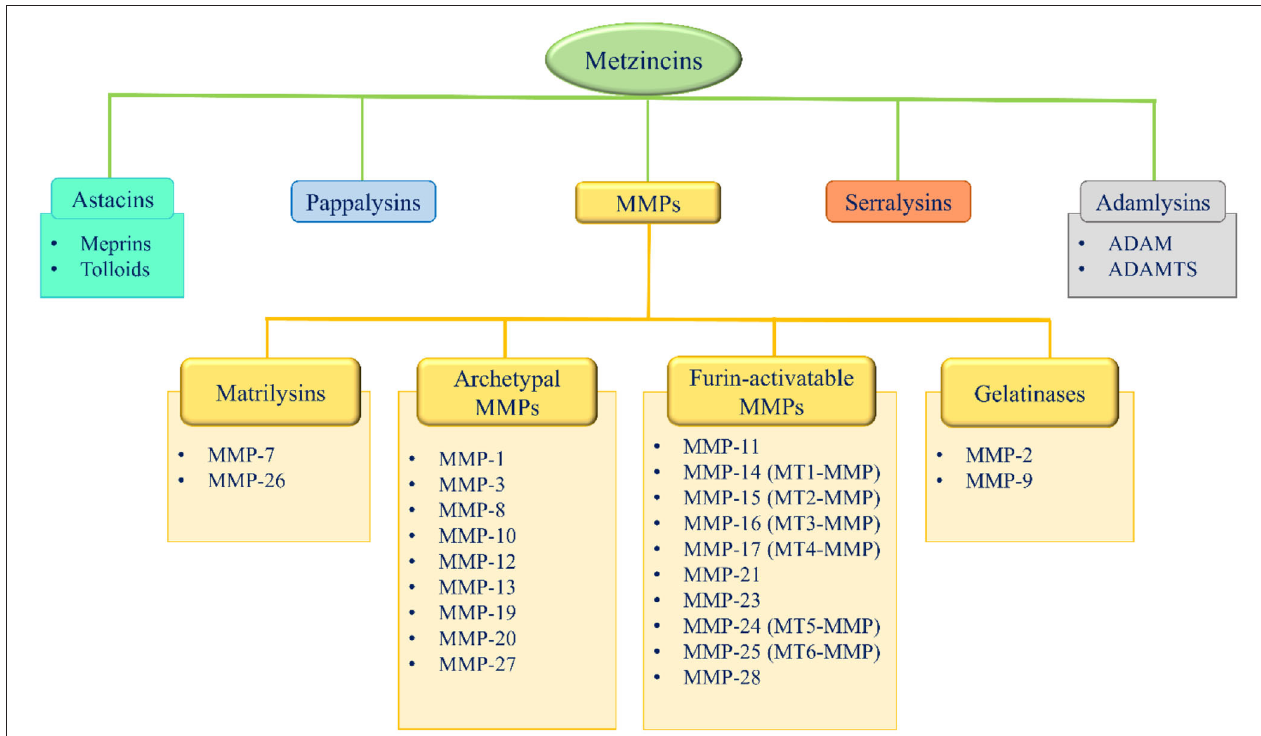
FIGURE 2 | Metzincins superfamily members and classification of MMPs based on their domain arrangement. MMP, metalloproteinase; MT-MMP, membrane-type MMP; ADAM, a desintegrin and metalloproteinase; ADAMTS, a-desintegrin and metalloproteinase with thrombospondin